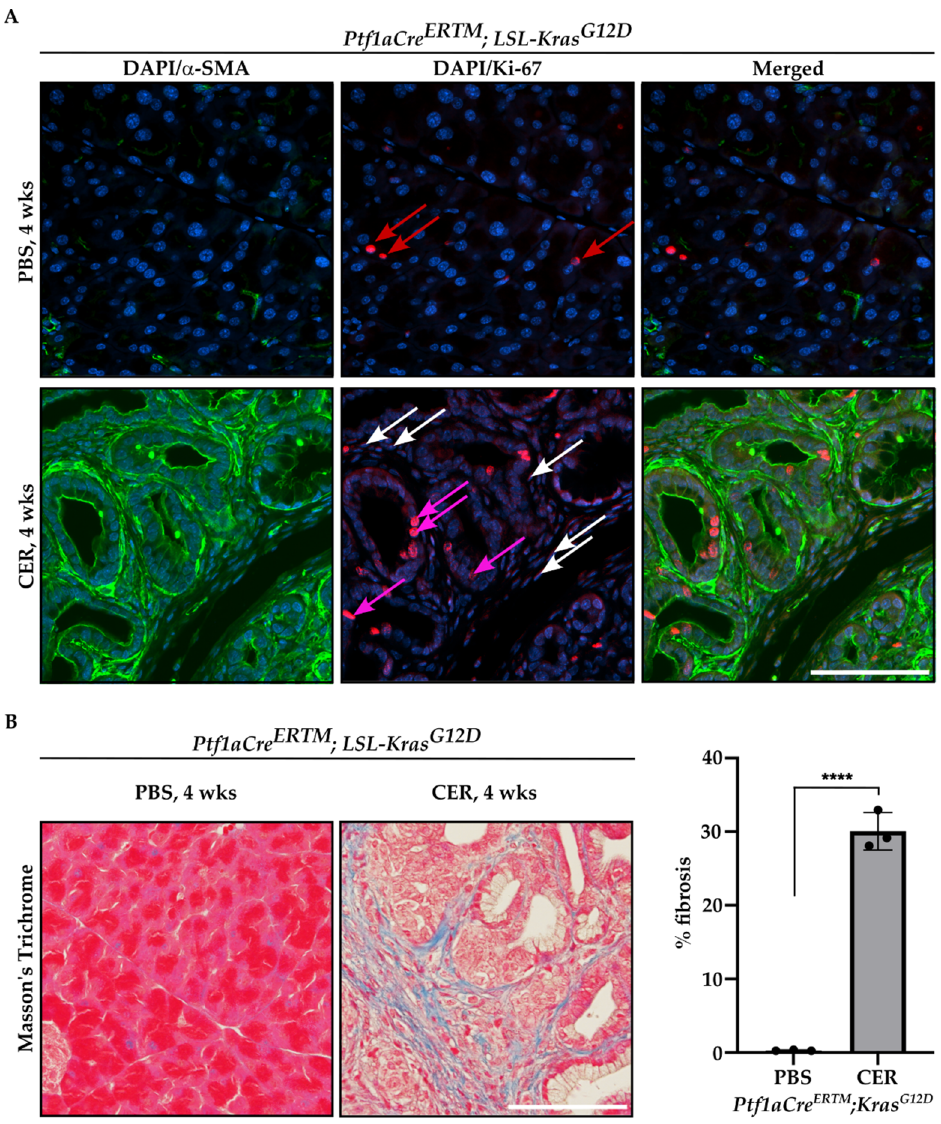
Figure 3. Proliferation and fibrosis are increased during the development of chronic pancreatitis. Pancreatic specimens were obtained from Ptf1aCre ERTM ;LSL-Kras G12D mice treated with tamoxifen for one week and subsequently with PBS (vehicle) or CER (cerulein) for four weeks. ( A ) Immunofluo- rescence staining of DAPI/ α SMA, DAPI/Ki-67, and DAPI/ α SMA/Ki-67, red arrows mark Ki-67 + cells in pancreas obtained from Ptf1aCre ERTM ;LSL-Kras G12D mice treated with PBS, white arrows mark stromal cells positive for Ki-67 + and pink arrows mark early pancreatic neoplastic cells positive for Ki-67 + in pancreas obtained from Ptf1aCre ERTM ;LSL-Kras G12D mice treated with CER, and ( B ) repre- sentative Masson’s Trichrome staining with quantification. The scale bar represents 100 µ m. Data are represented as the mean ± SD; N = 3. **** p < 0.0001 using t